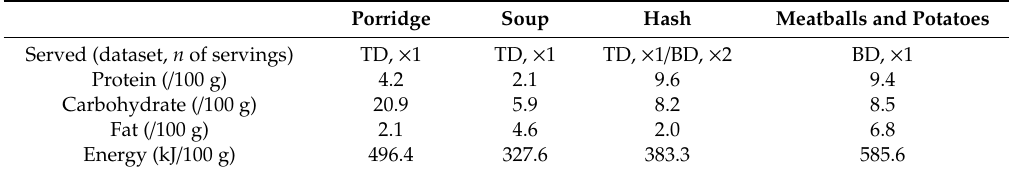
Table 1. Nutritional characteristics of the foods served in the meals of the TD and BD. Porridge Soup Hash Meatballs and Potatoes